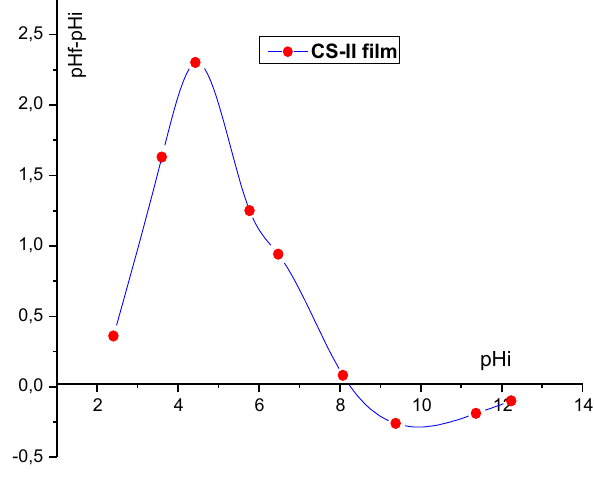
Fig. 7 Determination of pHpzc of CS-II